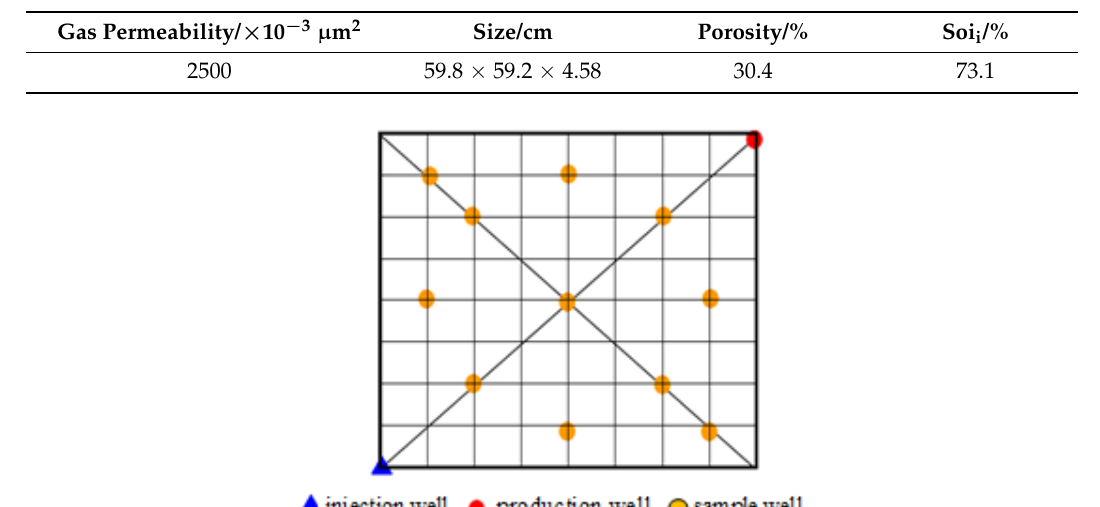
y = 0.0947x y = 0.0947x